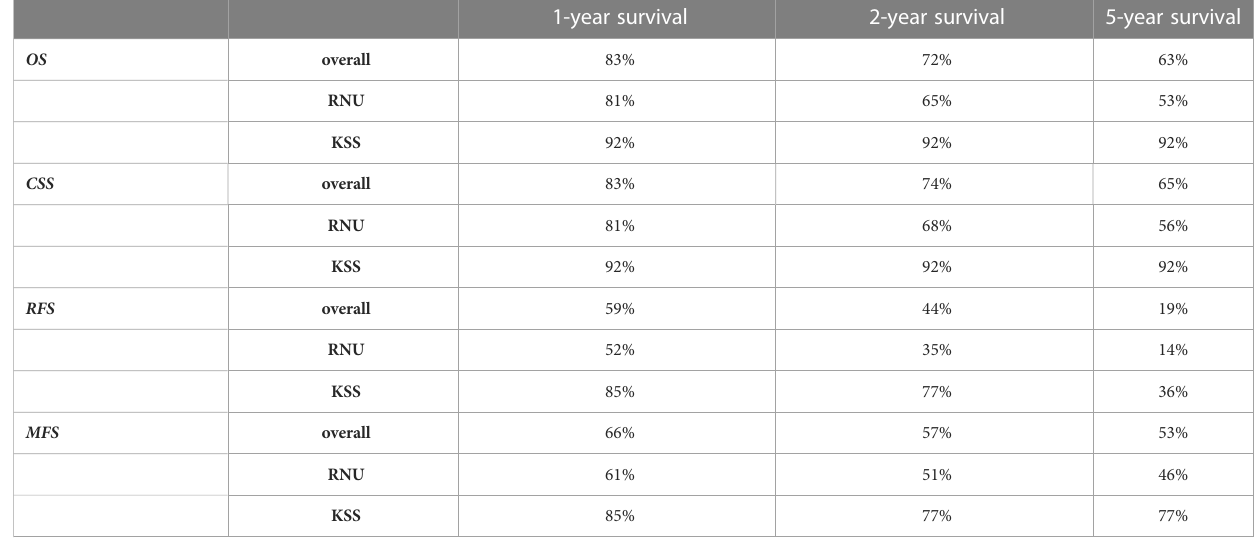
TABLE 2 Cumulative 1 -, 2 -, and 5 - year survival.